Question: Express in one sentence what the figure is showing.
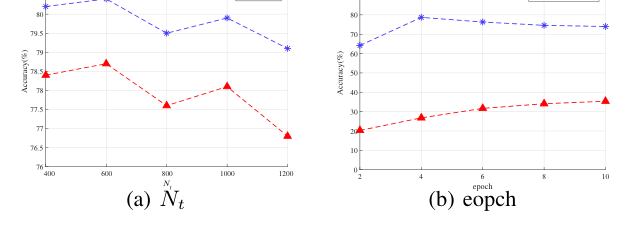
Answer: (a) represents the influence of varying the number of ran- dom prototypes on the map and top-1 metrics on the CUHK-SYSU dataset. (b) illustrates the impact of different pre-training rounds on two datasets.